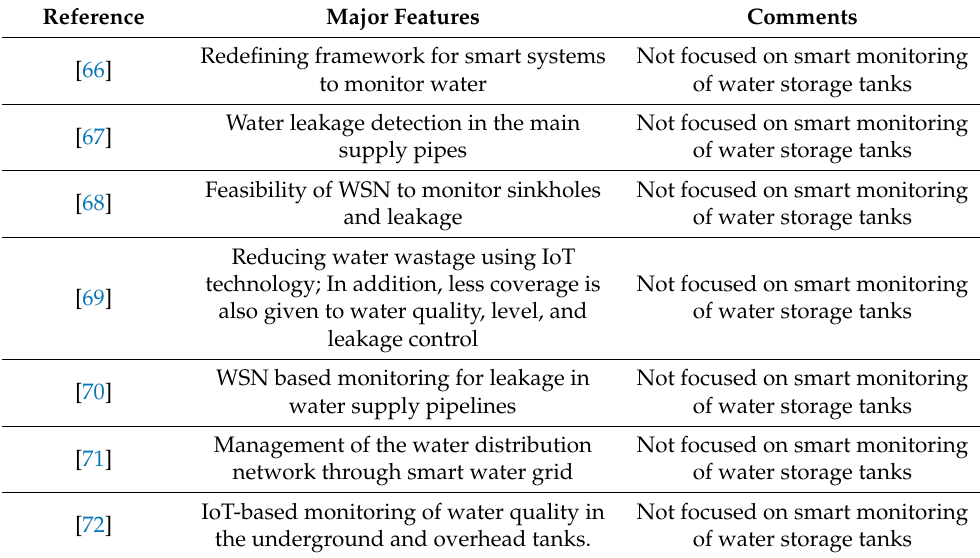
Table 1. Contemporary reviews on smart water monitoring.